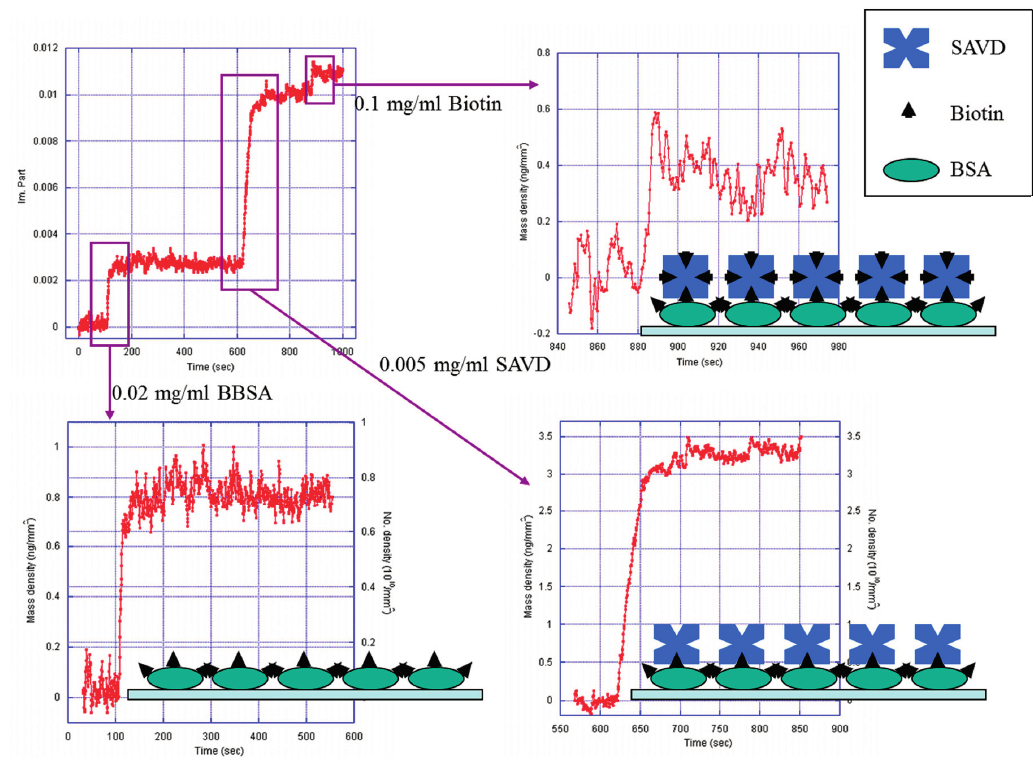
Figure 5. Kinetics of streptavidin binding to biotinylated BSA: Kinetic curve of biotinylated BSA (0.3 μ M) binding to epoxy surface, streptavidin (83 nM) binding to biotin, and biotin (0.1 mg/mL) binding to streptavidin. Cartoon depictions of all processes are also